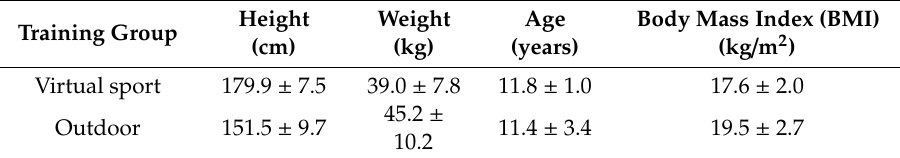
Table 1. Physical characteristics of the training groups